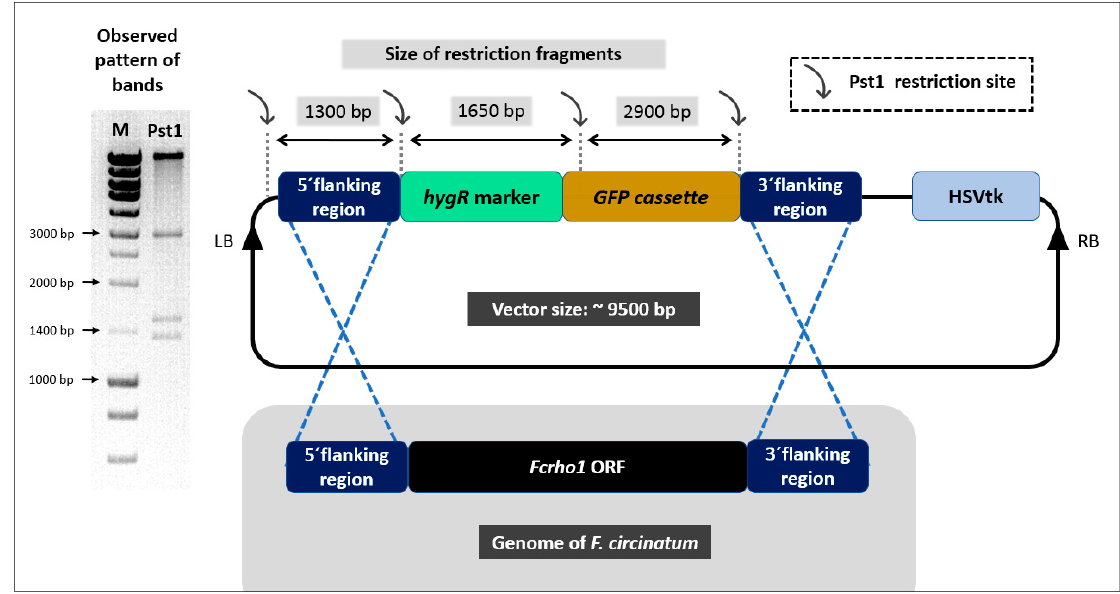
Figure 1. Deletion construction formed using a modified version of the OSCAR protocol. LB/RB: left/right border. M: NZYDNA Ladder III; Pst1: band pattern obtained after DNA digestion with Pst1 restriction enzyme.